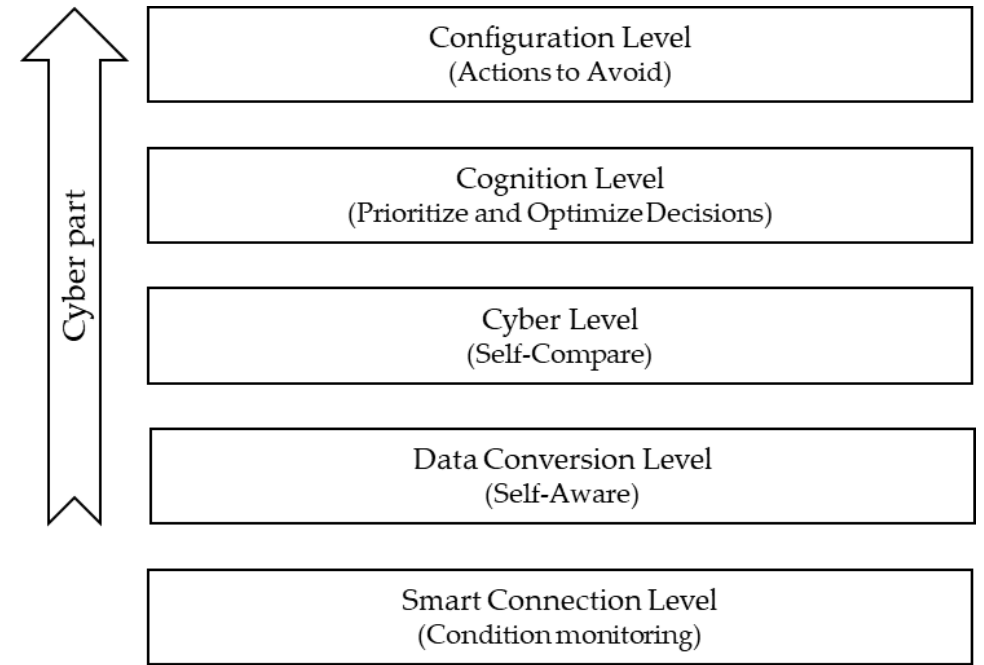
Figure 1. CPPS 5C architecture, reformatted after [10].